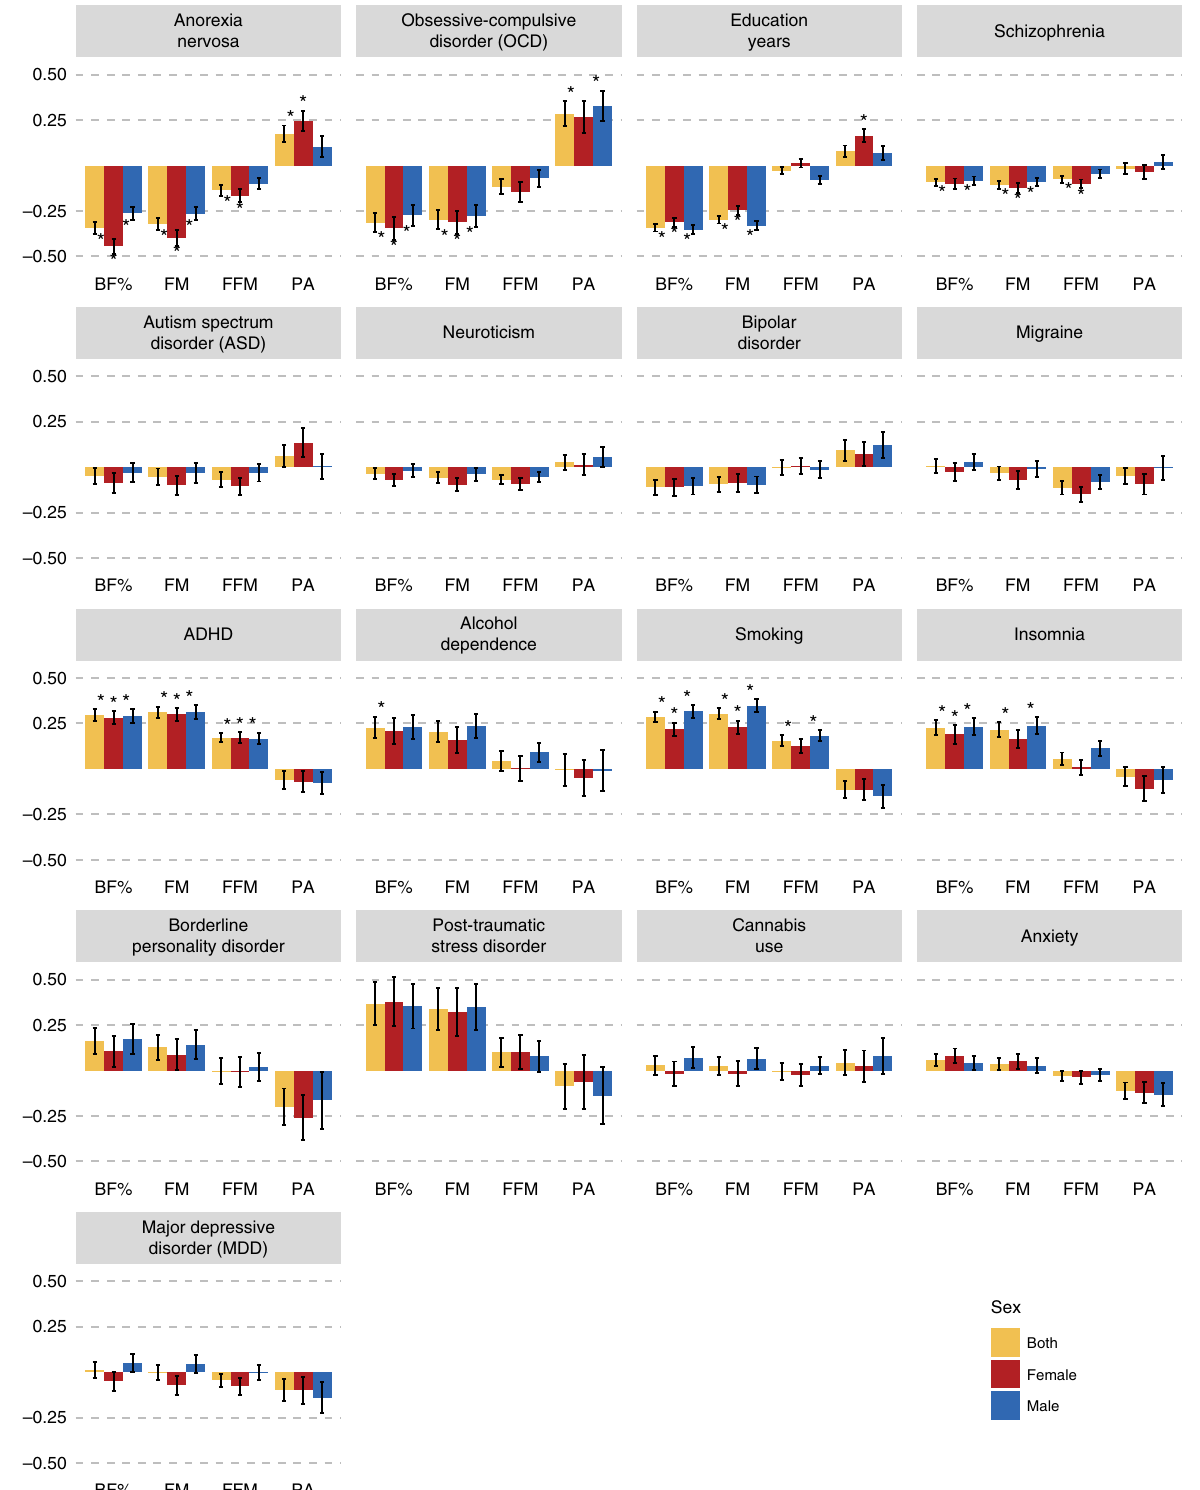
Fig. 1 Sex-speci fi c genetic correlations across body composition, physical activity and psychiatric traits. Sex-speci fi c genetic correlations of body composition traits ( n = up to 155,961) and physical activity ( n = up to 66,224) with sex-combined psychiatric disorders ( n = up to 77,096) and behavioural traits ( n = up to 157,355). The autosomal genetic correlations were calculated by bivariate linkage disequilibrium score regression (LDSC). Coloured bars represent genetic correlations, error bars depict standard errors (s.e.) and asterisks indicate statistically signi fi cant genetic correlations with p values less than α = 0.0003. This threshold was calculated via the identi fi cation of the number of independent tests using matrix decomposition of the genetic correlation matrix and subsequent Bonferroni correction of α = 0.05 for 190 independent tests. ADHD = attention-de fi cit/hyperactivity disorder, BF% = body fat percentage, FFM = fat-free mass, FM = fat mass, PA = physical